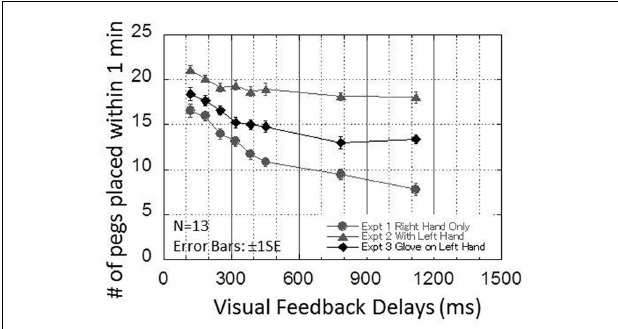
FIGURE 6 | Results obtained in experiment 3. This graph plots the performance of the pegboard task as a function of the visual delays from 120 to 1120ms in eight steps.The result obtained by the same 13 participants from experiments 1 and 2 are superimposed on the